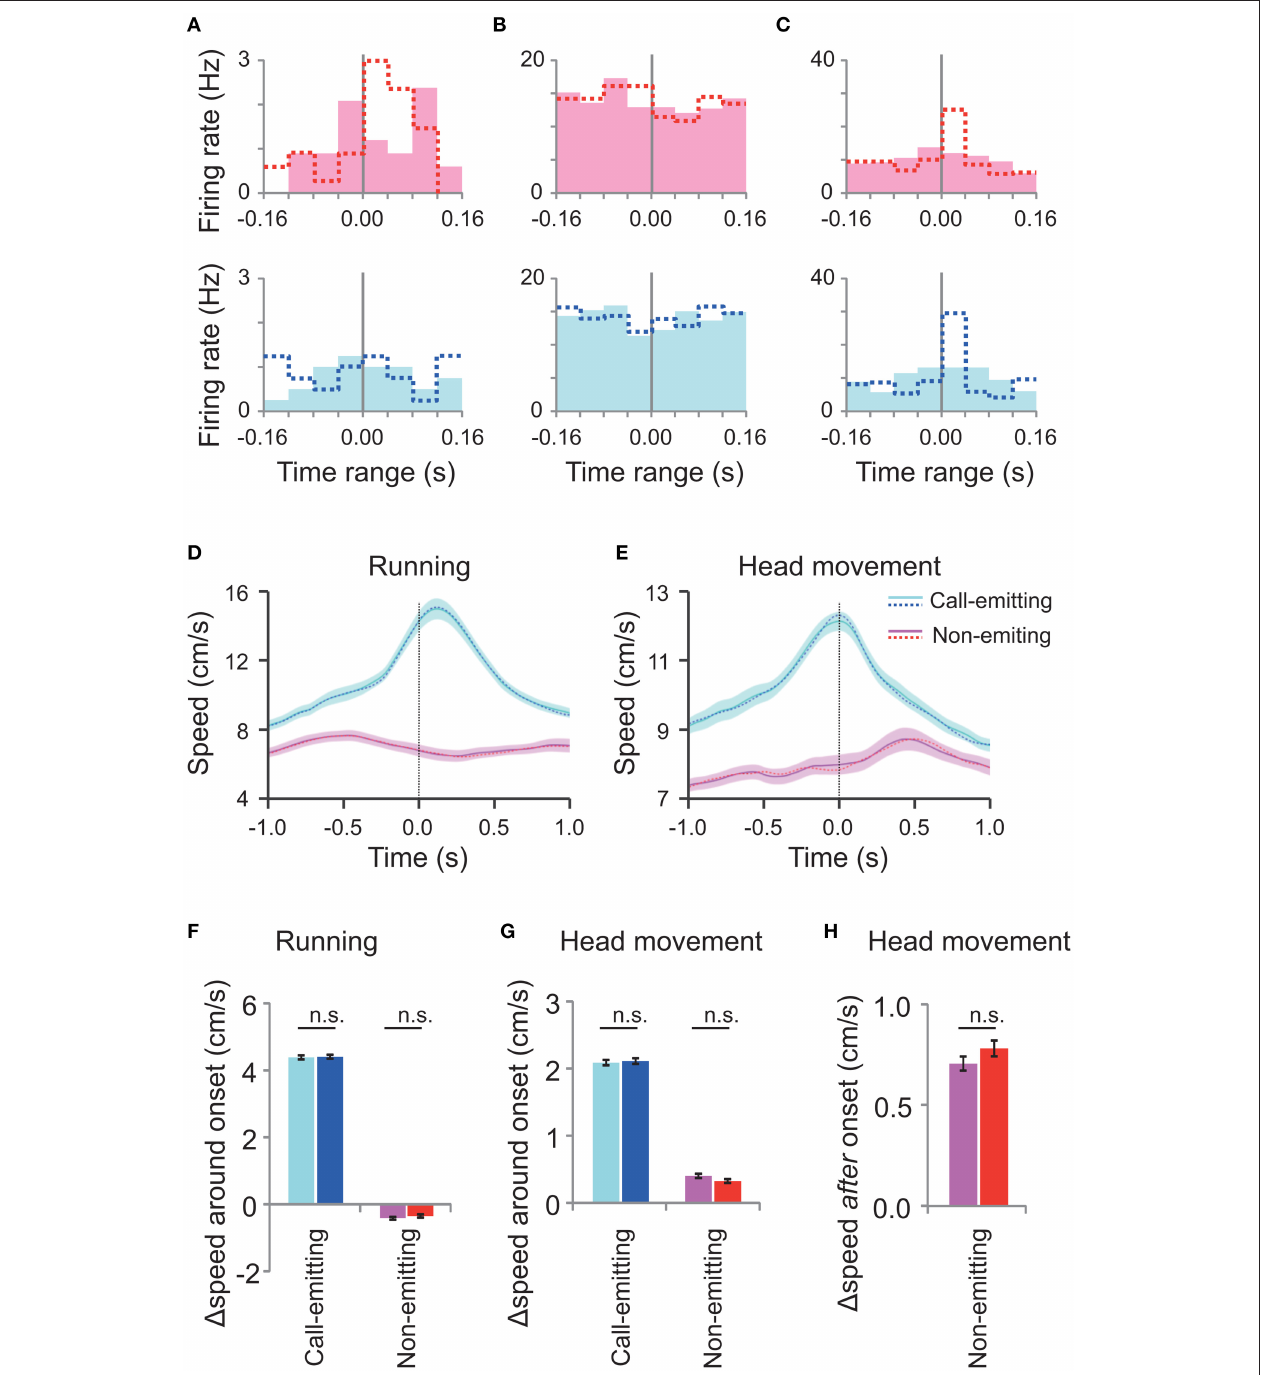
FIGURE 5 | Neuronal activity and rats’ motion around the randomly shifted call onsets. (A–C) Peri-event histograms of spike activity around the randomly shifted call onsets (filled bars) of neurons shown in Figures 4A–C , respectively. Dotted lines indicate original responses. Responses to the call by the conspecific (pink) are displayed above and those of the subject (blue) below. (D,E) Average running (D) and head movement (E) speeds of interacting male subject and conspecific rats (30 rats; 27 M sessions) around the randomly shifted call onsets by the call-emitting (light blue) and non-emitting (pink) rats and the original data before the random shift (dotted line). The other descriptions are the same as those for Figures 3C,D . (F,G) The change in running speed and head movement around the randomly shifted onsets (left; light blue and pink) and original ones (right; blue and red) of either the call-emitting (light blue/blue) or non-emitting (pink/red) rats. Note that the speeds at the different onsets showed no significant difference (paired t -test, p > 0.05). Other descriptions are the same as those for Figures 3E,F . (H) Comparison of head movement after the random-shifted onsets (left) and original ones (right) of the non-emitting rats. The speed changes for the different onsets were not significantly different (paired t -test between the data before and after the random shift, p > 0.05). Other descriptions are the same as those for Figure 3G .